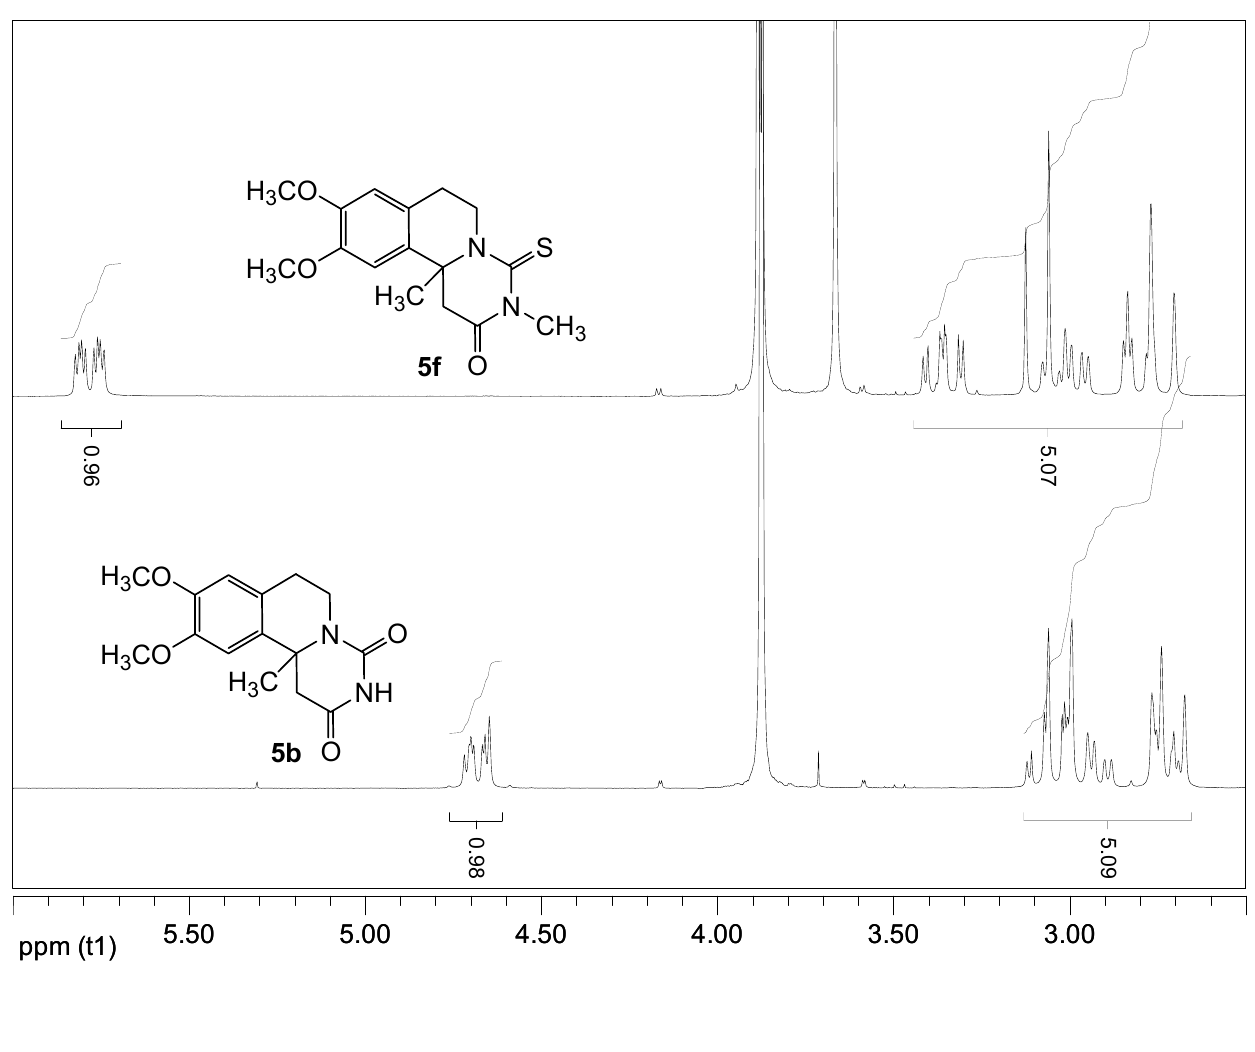
Figure 1. Representative 1 H-NMR cuts (2.5 – 6.0 ppm region) showing the methylene signals and the downfield shift of the equatorial hydrogen at